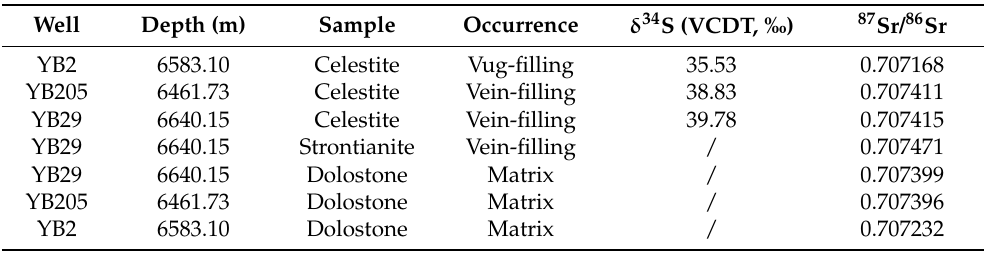
Table 1. δ 34 S and 87 Sr/ 86 Sr values for the celestite and strontianite minerals and the host rock dolostones in the P 3 c in the YB gas